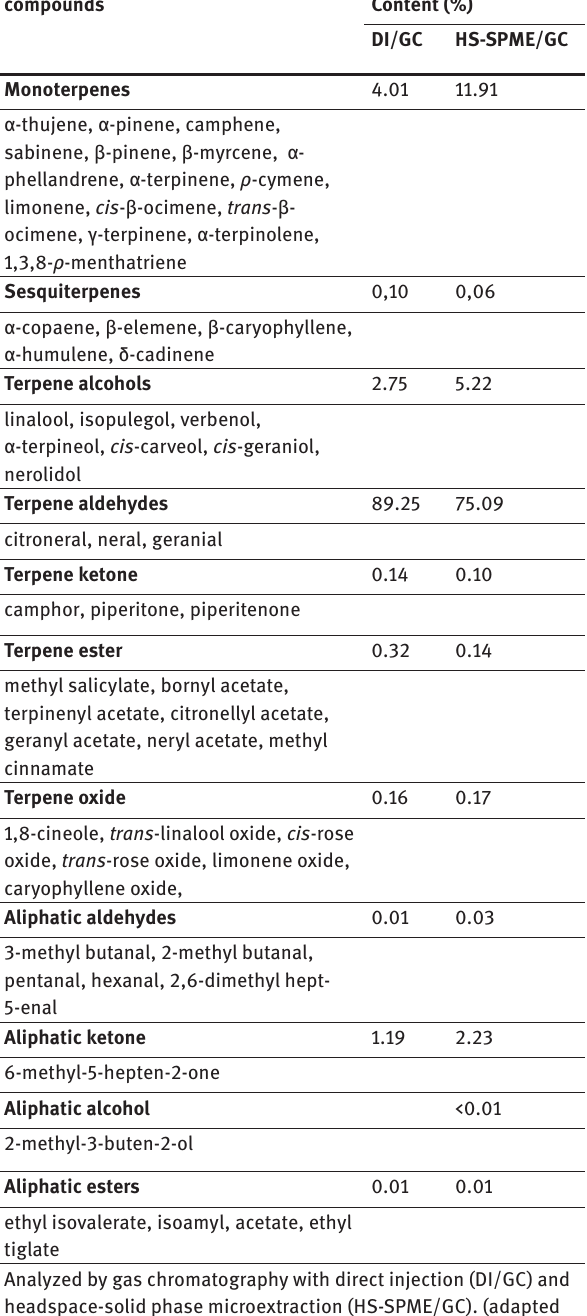
Table 2: Chemical composition of LcEO.